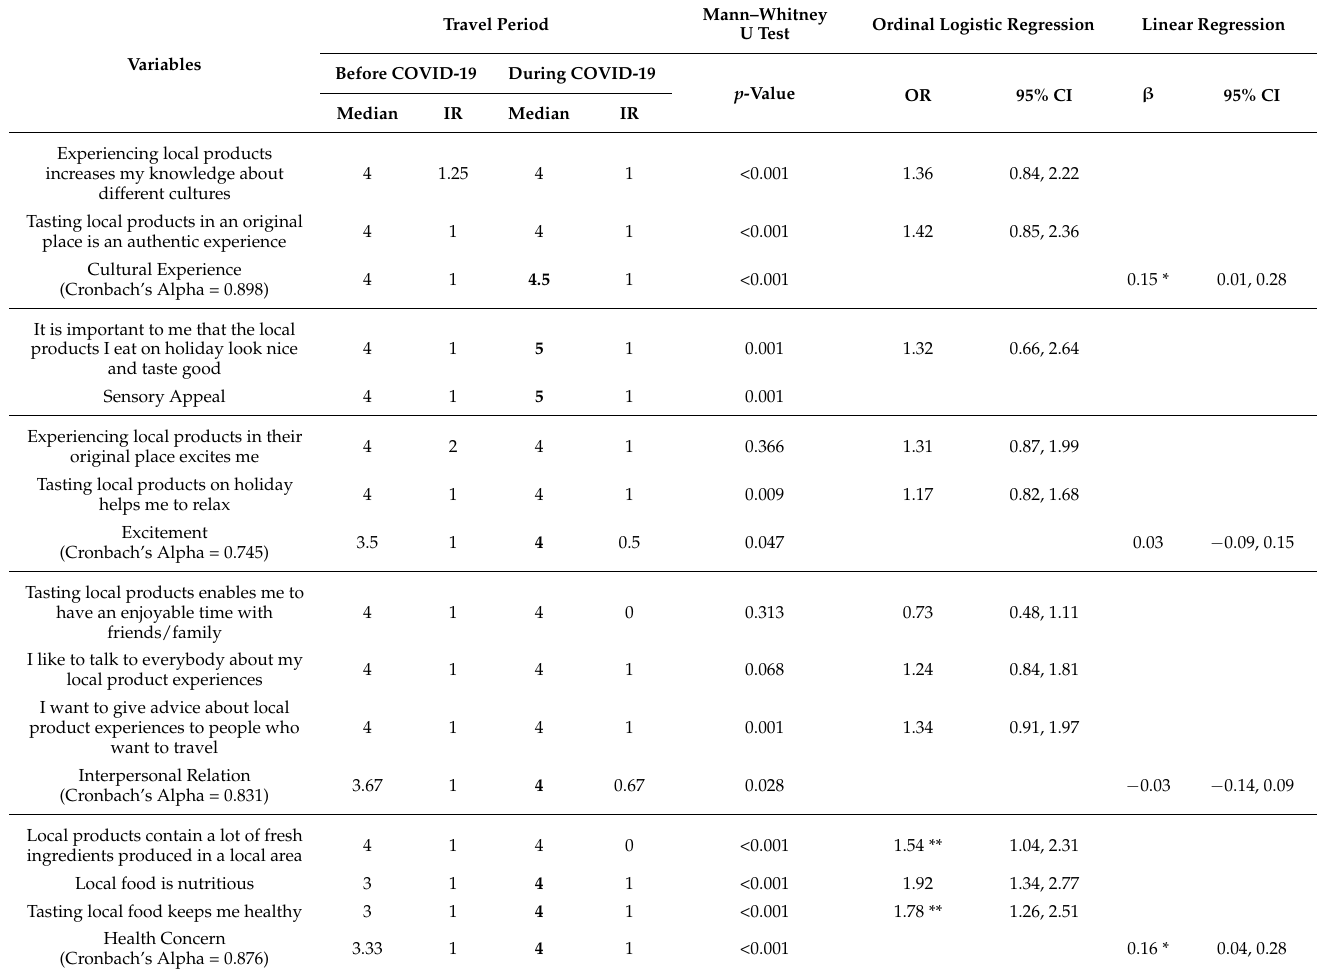
Table 7. Food motivations of tourists in each